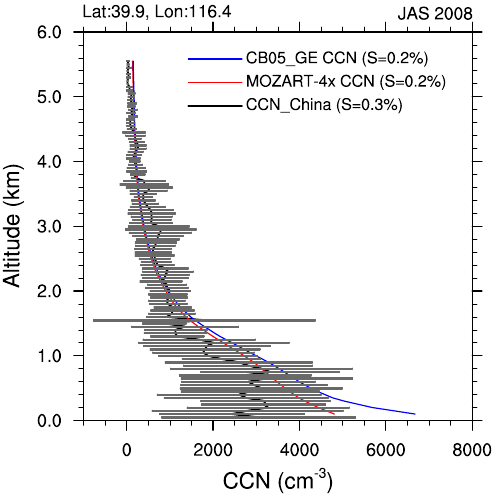
Figure 5. Simulated vertical profiles of CCN against aircraft mea- surements. The black solid line represents observations from air- craft measurements of Zhang et al. (2011). The red solid and blue solid lines represent model output from MOZART-4x and CB05_GE, respectively.